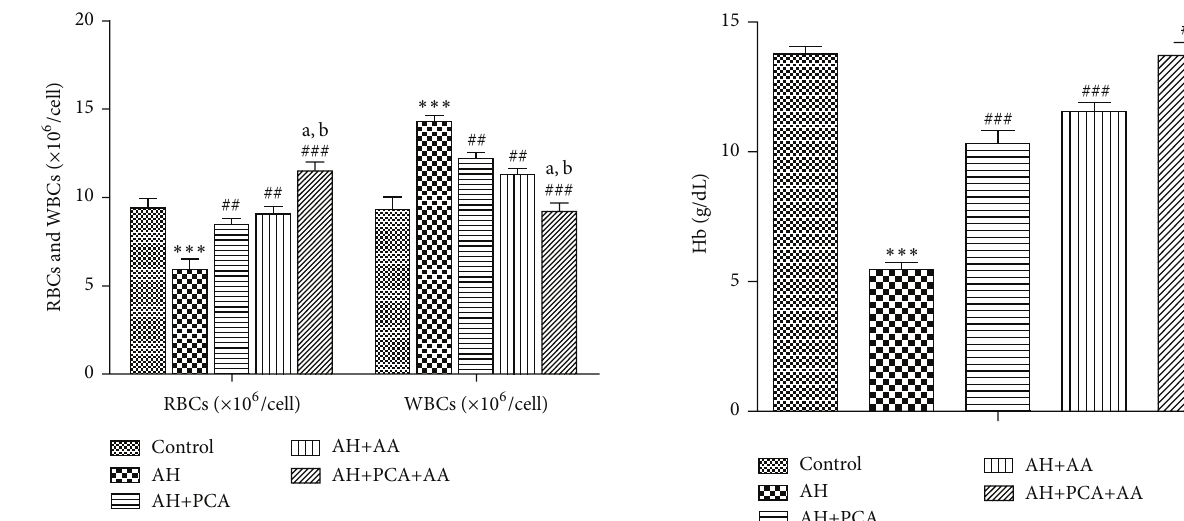
Figure 2: Effect of PCA alone and in combination with AA on haemoglobin in AH-treated rats. Values are expressed as mean ± SEM. Level of significance is considered as ∗ 𝑝 < 0.05 , ∗∗ 𝑝 < 0.01 , and ∗∗∗ 𝑝 < 0.001 compared to control group. # 𝑝 < 0.05 , ## 𝑝 < 0.01 , and ### 𝑝 < 0.001 compared to AH-treated group. a 𝑝 < 0.05 compared to AH+PCA and b 𝑝 < 0.05 compared to AH+AA group.